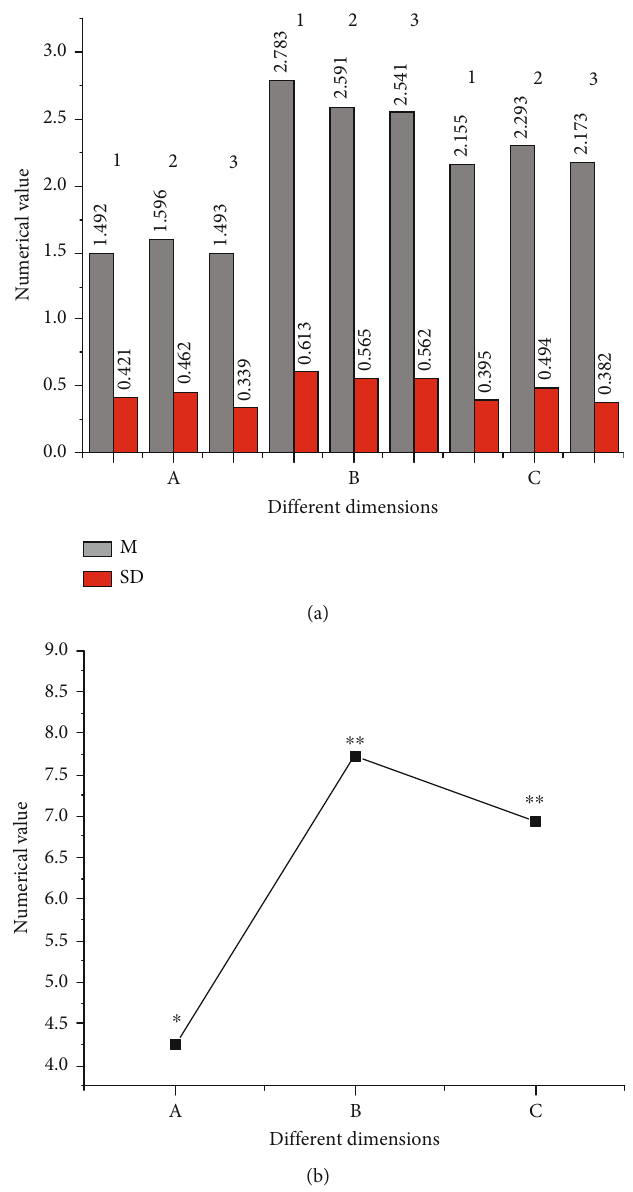
Figure 11: Comparison results of parenting styles of mothers with di ff erent education levels: (a) mean and standard deviation of the LSD test; (b) F value of the LSD test; A: mother ’ s rejection; B: mother ’ s emotional warmth; C: mother ’ s overprotection; ∗ P < 0 : 05 ; ∗∗ P < 0 : 01 ; 1: above junior college; 2: high school/technical secondary school; 3: junior high